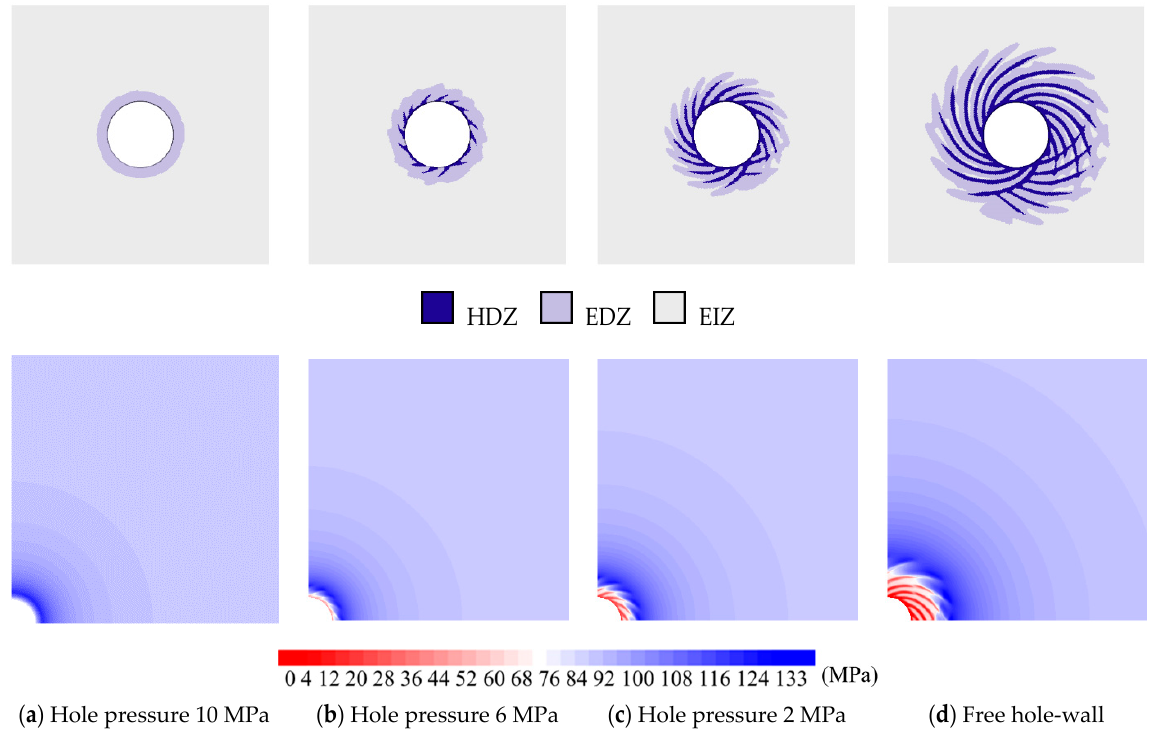
Figure 9. Progressive changes of surrounding rock caused by inner boundary unloading: growth of failure zones (the upper) and contour of the maximum principal stress (the lower).